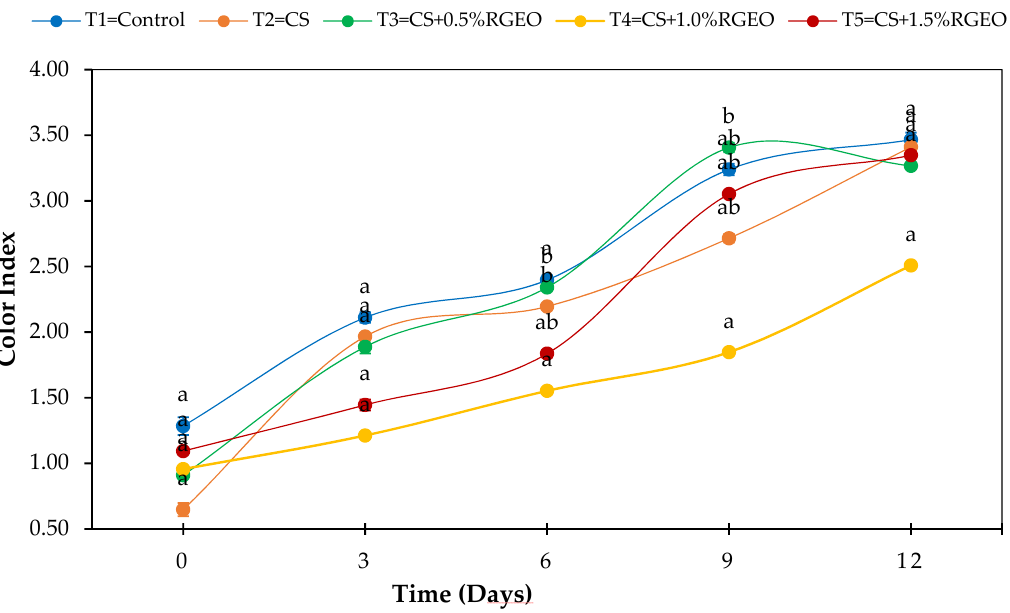
Figure 3. The color index in the fruits of cape gooseberries during the 12 days of storage covered with each treatment. The superscript letter (a–d) refers to the significant differences ( p < 0.05) between each treatment.